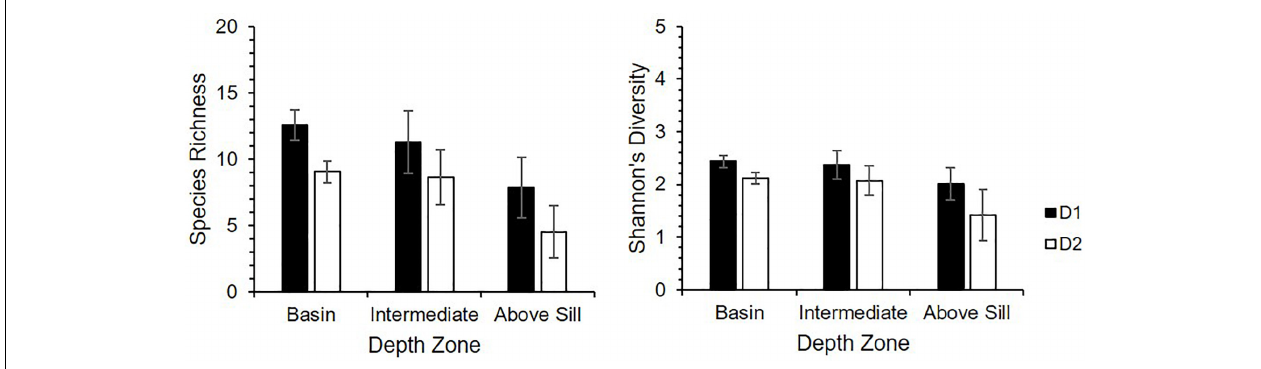
FIGURE 6 | Averaged diversity indices (species richness and Shannon-Wiener diversity index) per depth zone of the Dive 1 (D1; closed) and Dive 2 (D2; open) presence-absence community data in relation to the three depth zones in Sognefjord, Norway. Error bars represent 95% confidence intervals.